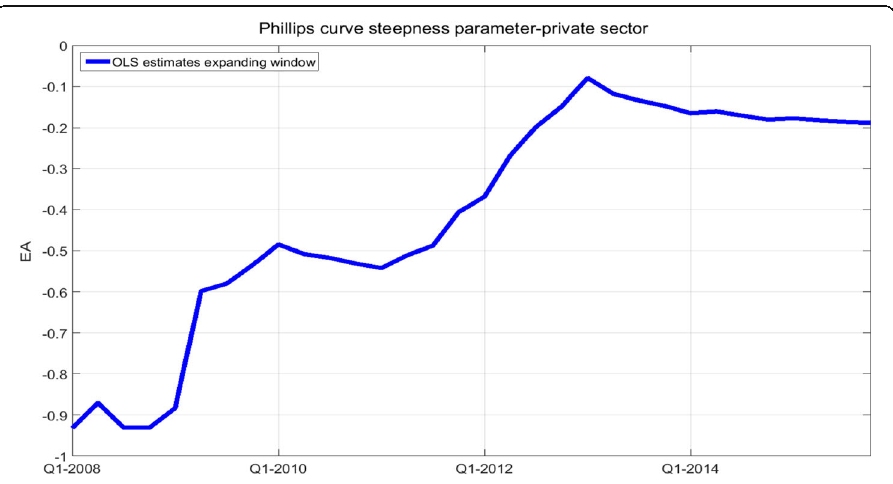
Fig. 2 Phillips curve expanding window regressions in the euro area. The blue lines show the OLS estimates of the parameter of unemployment rate for different samples: the first point refers to the sample 1999Q1 – 2008Q1 and the last point refers to the sample 1999Q1 –